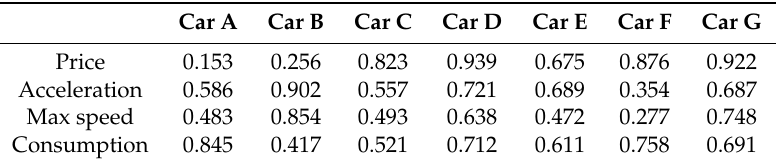
Table 2. The partial evaluations of the seven types of cars.